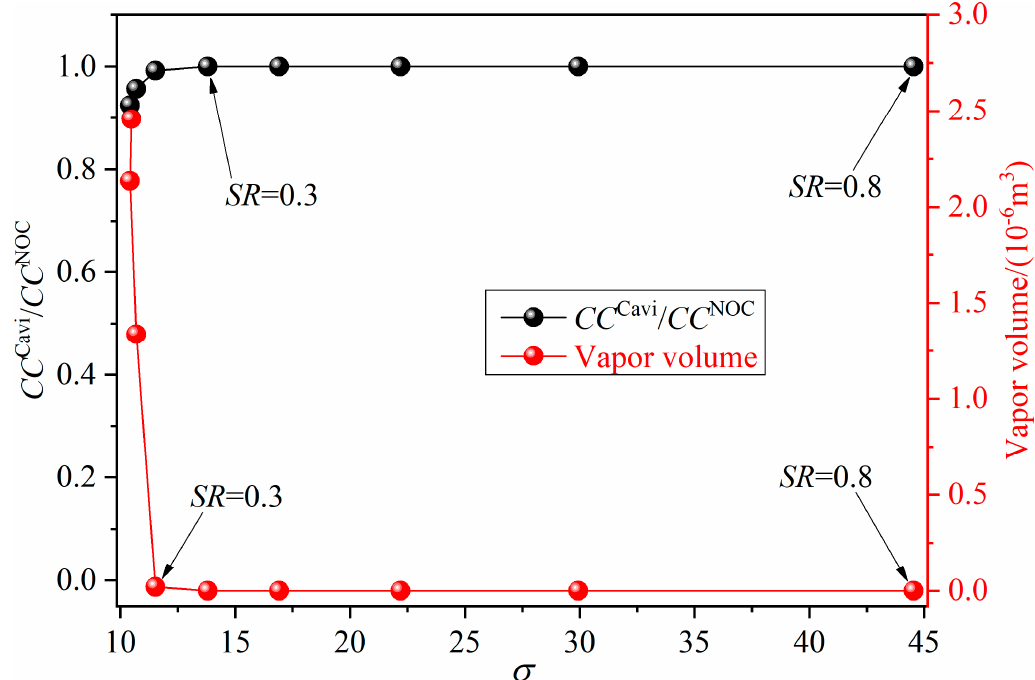
σ ). Figure 12. Non-dimensional capacity constant and vapor volume under various dimensionless cavitation numbers ( σ